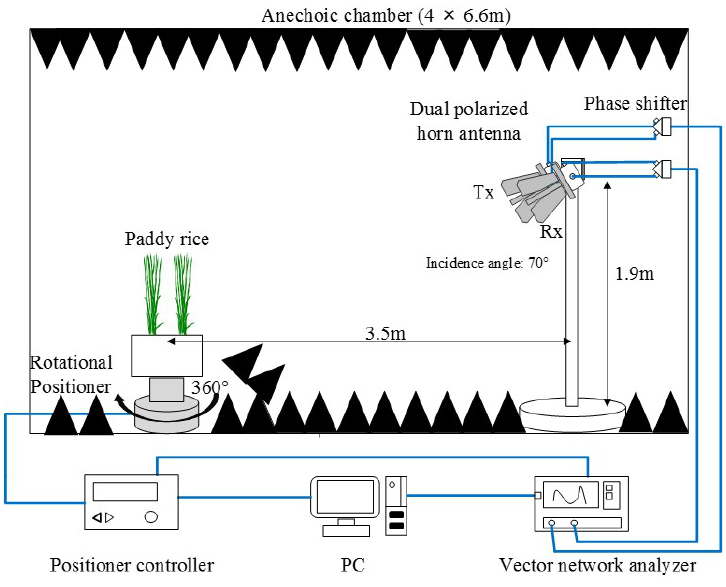
Figure 3. Experimental geometry inside an anechoic